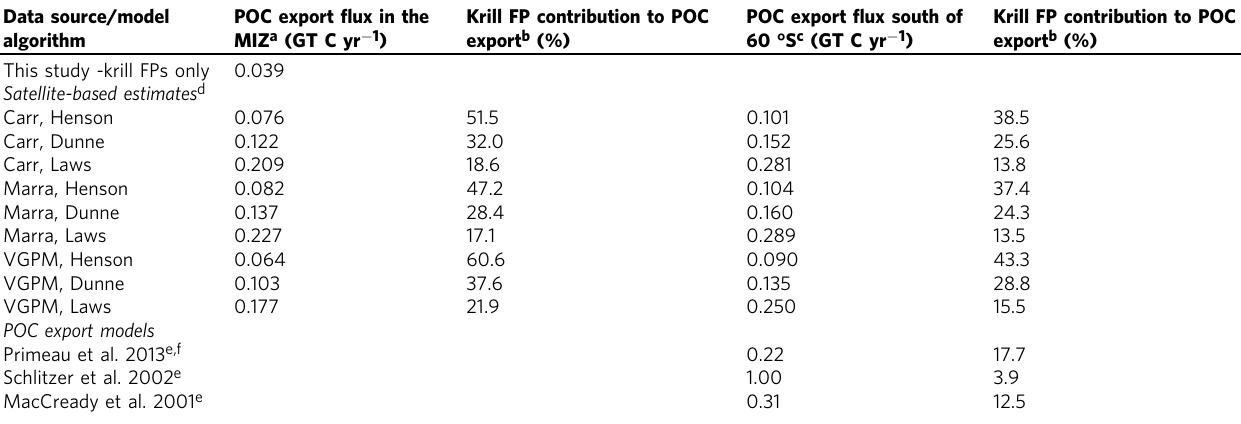
Table 1 Comparison of krill faecal pellet (FP) POC export at 100 m (this study) with literature estimates of total POC export Data source/model